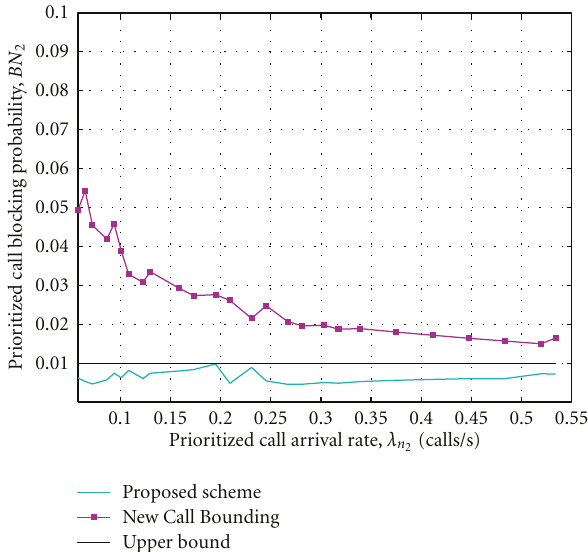
Figure 2: The mean response time of nonprioritized calls versus prioritized calls arrival rate.